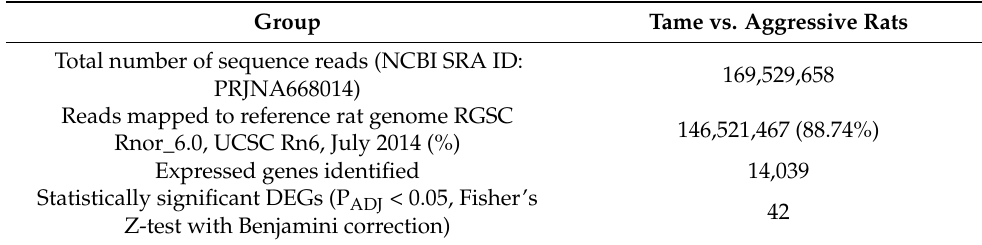
Table 1. Summary of searches for differentially expressed genes (DEGs) in hippocampal transcrip- tomes of three tame adult male rats ( Rattus norvegicus ) and three aggressive ones (all unrelated) in this